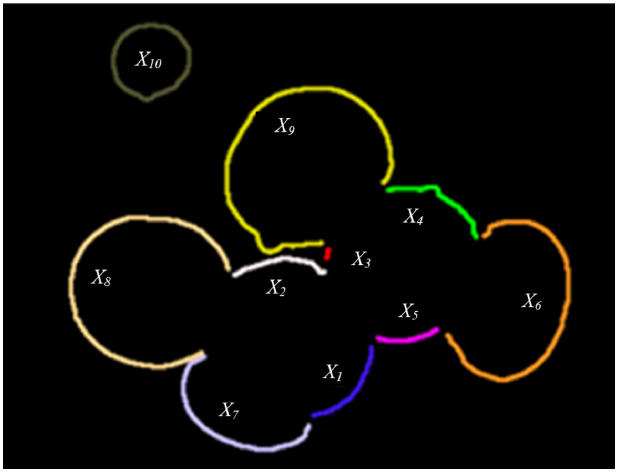
Figure 9. The contour representation after segmentation.